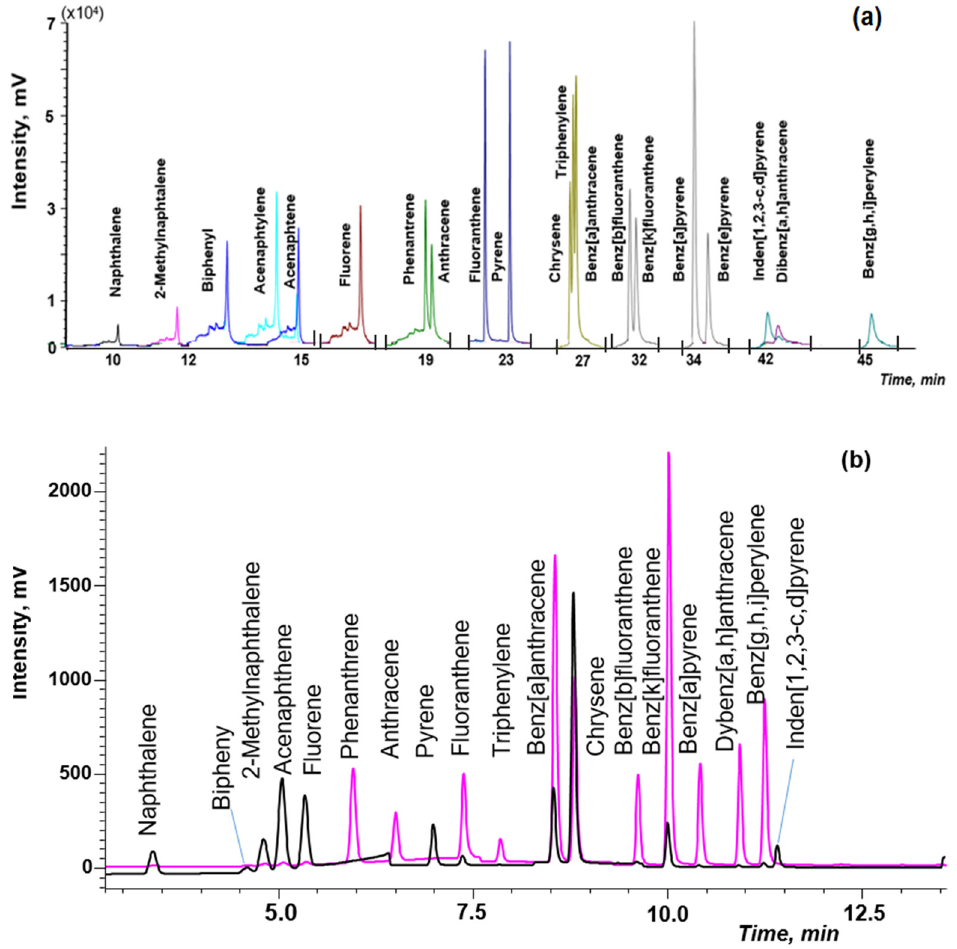
Figure 5. The chromatogram of the standard PAHs solution (50 ng/mL) by: ( a ) gas chromatography and mass spectrometry (GC-MS); ( b ) high-performance liquid chromatography and fluorescence detector (HPLC-FD).